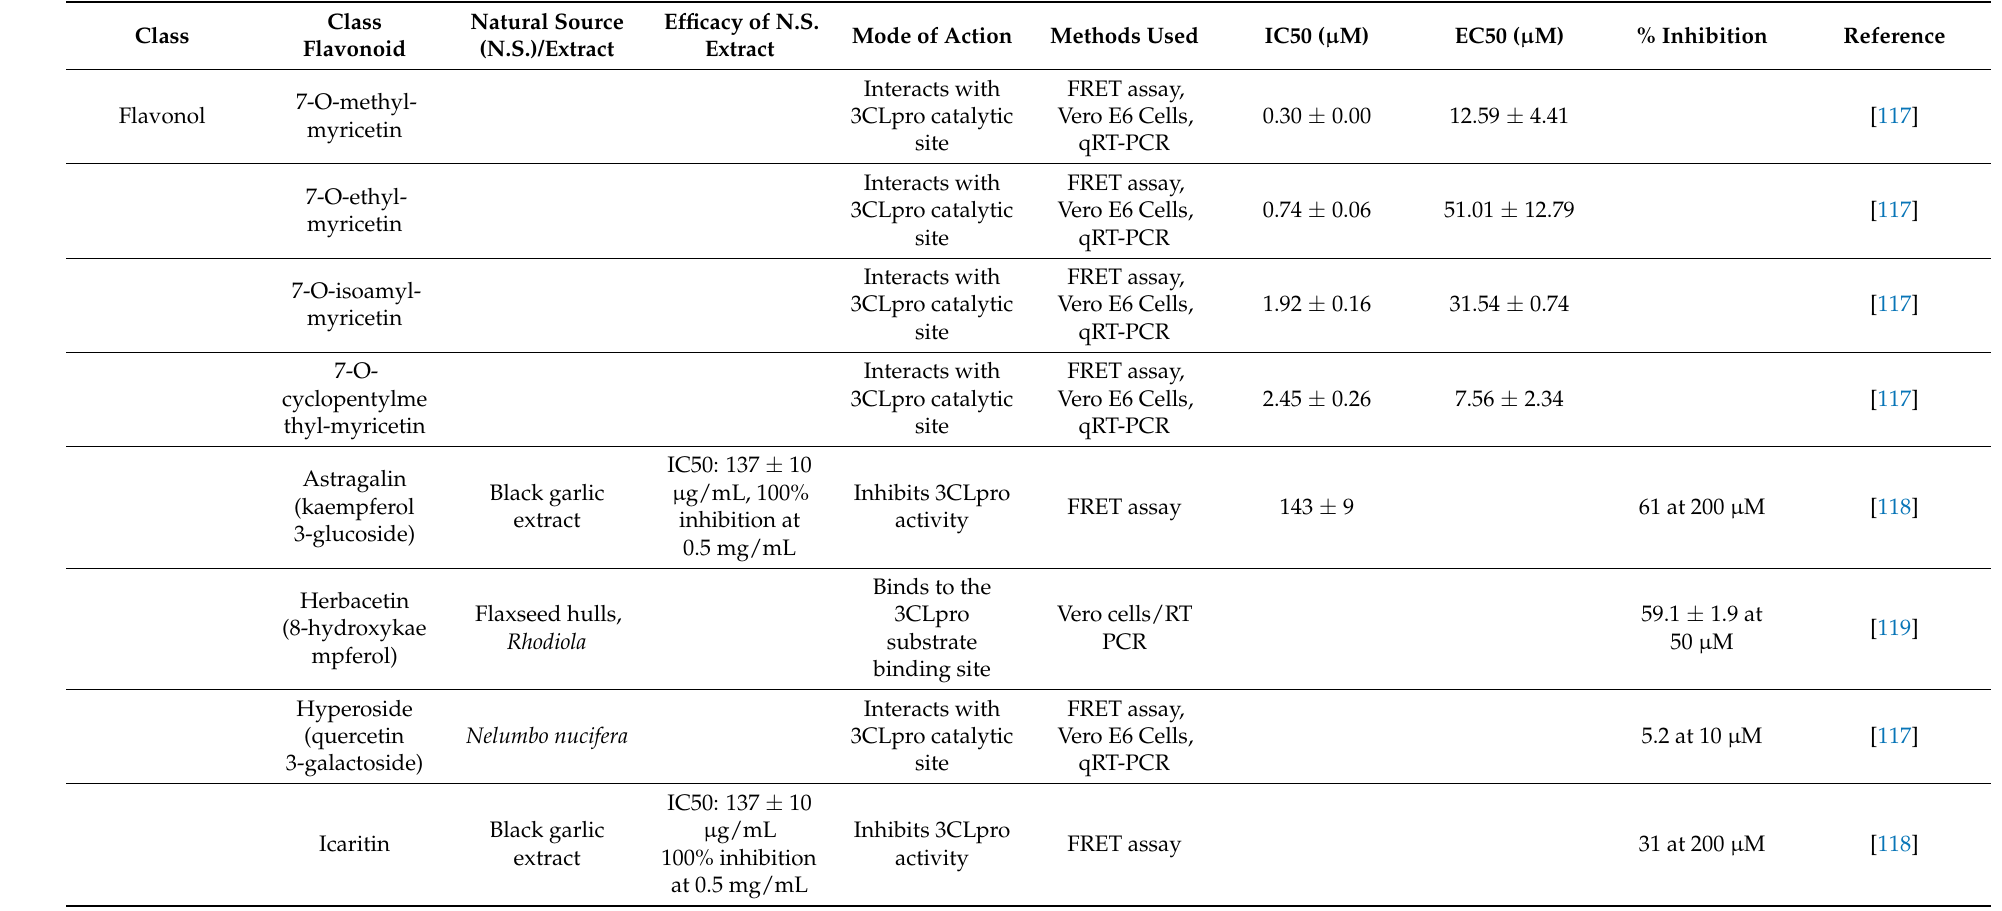
Table 1. Flavonoids with antiviral activities reported against SARS-CoV-2 3CLpro using in vitro methodologies segregated according to